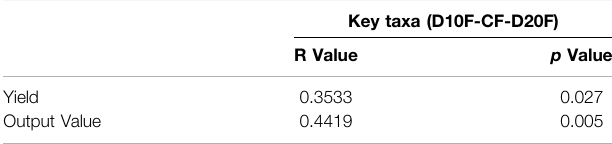
TABLE 4 | Mantel test analysis of correlations between key taxa and output value of tobacco